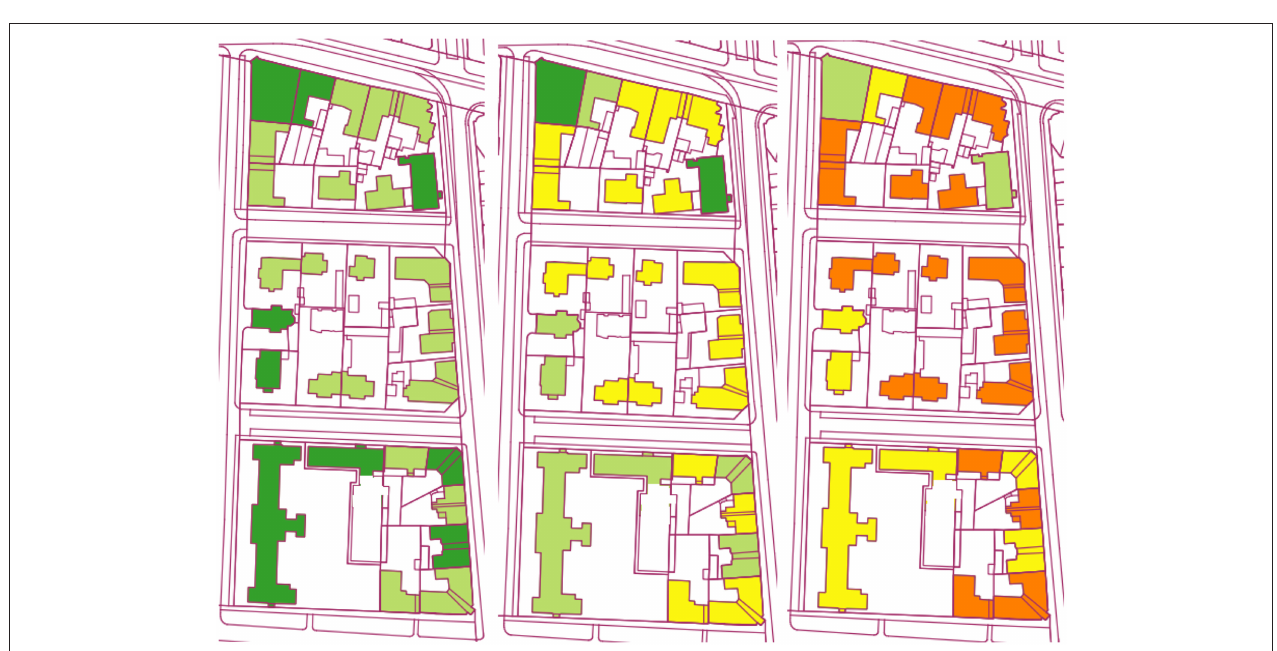
FIGURE 9 | Values of the mean damage grades for three levels of earthquake intensity: (A) VII, (B) VIII, and (C) IX.